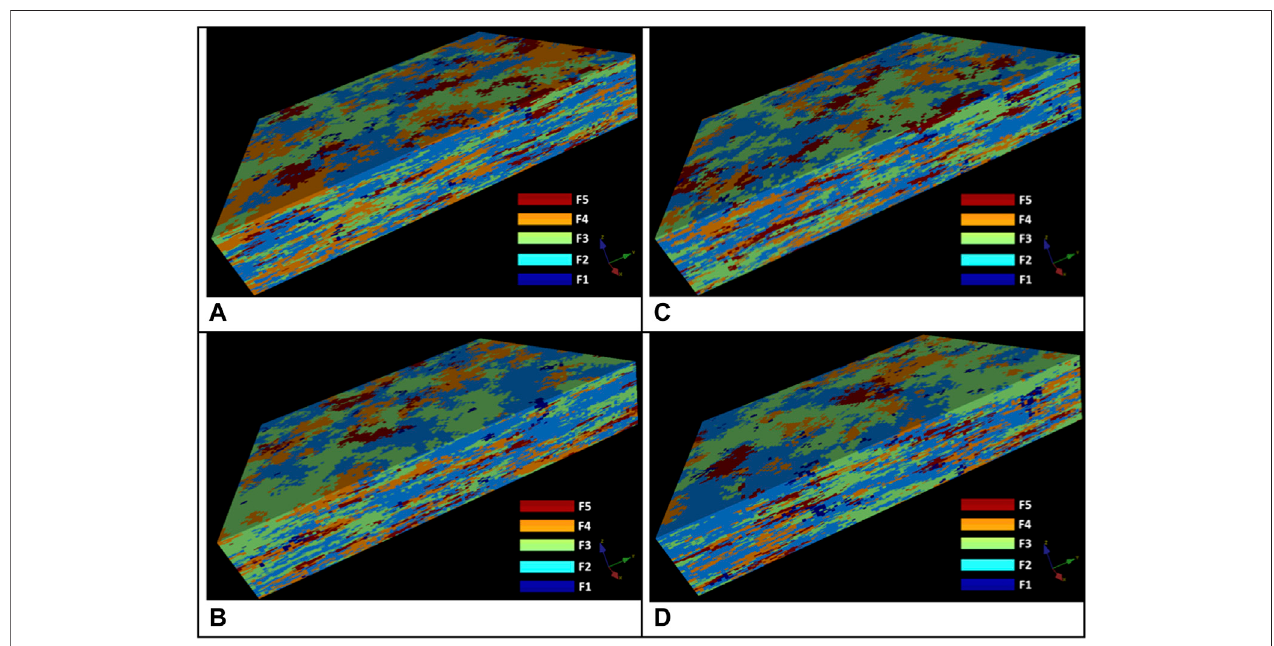
FIGURE 10 | 3D views of four simulations using the experimental proportions (A) simulation 1; (B) simulation 2; (C) simulation 3; (D) simulation 4.